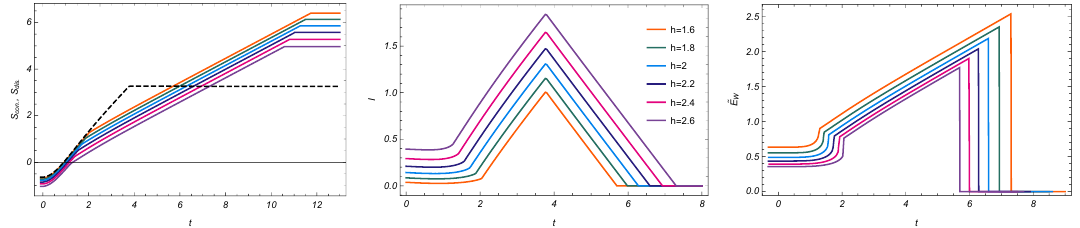
Figure 13 . The HEE (left), HMI (middle) and EWCS (right) as functions of boundary time for di(cid:11)erent values of the separation between subregions in a charged black brane geometry. The connected con(cid:12)guration is always favored for any boundary time and EWCS saturates to a (cid:12)nite value. Here we have set ‘ = 1 : 18 and d = 3.